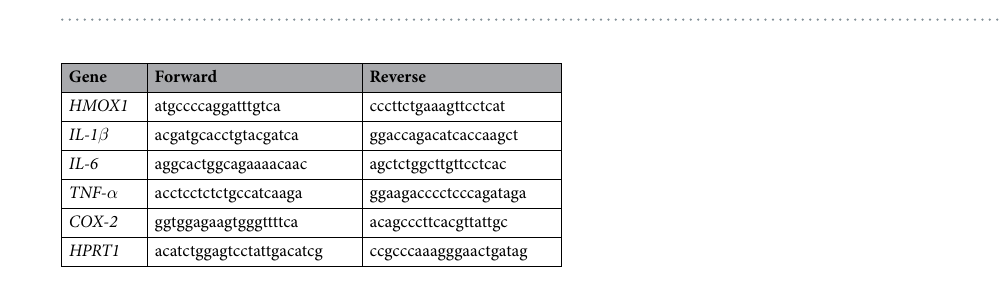
Table 3. List of rodent genes used for gene expression analyses. Hprt1 and Gapdh were used as the housekeeping genes.